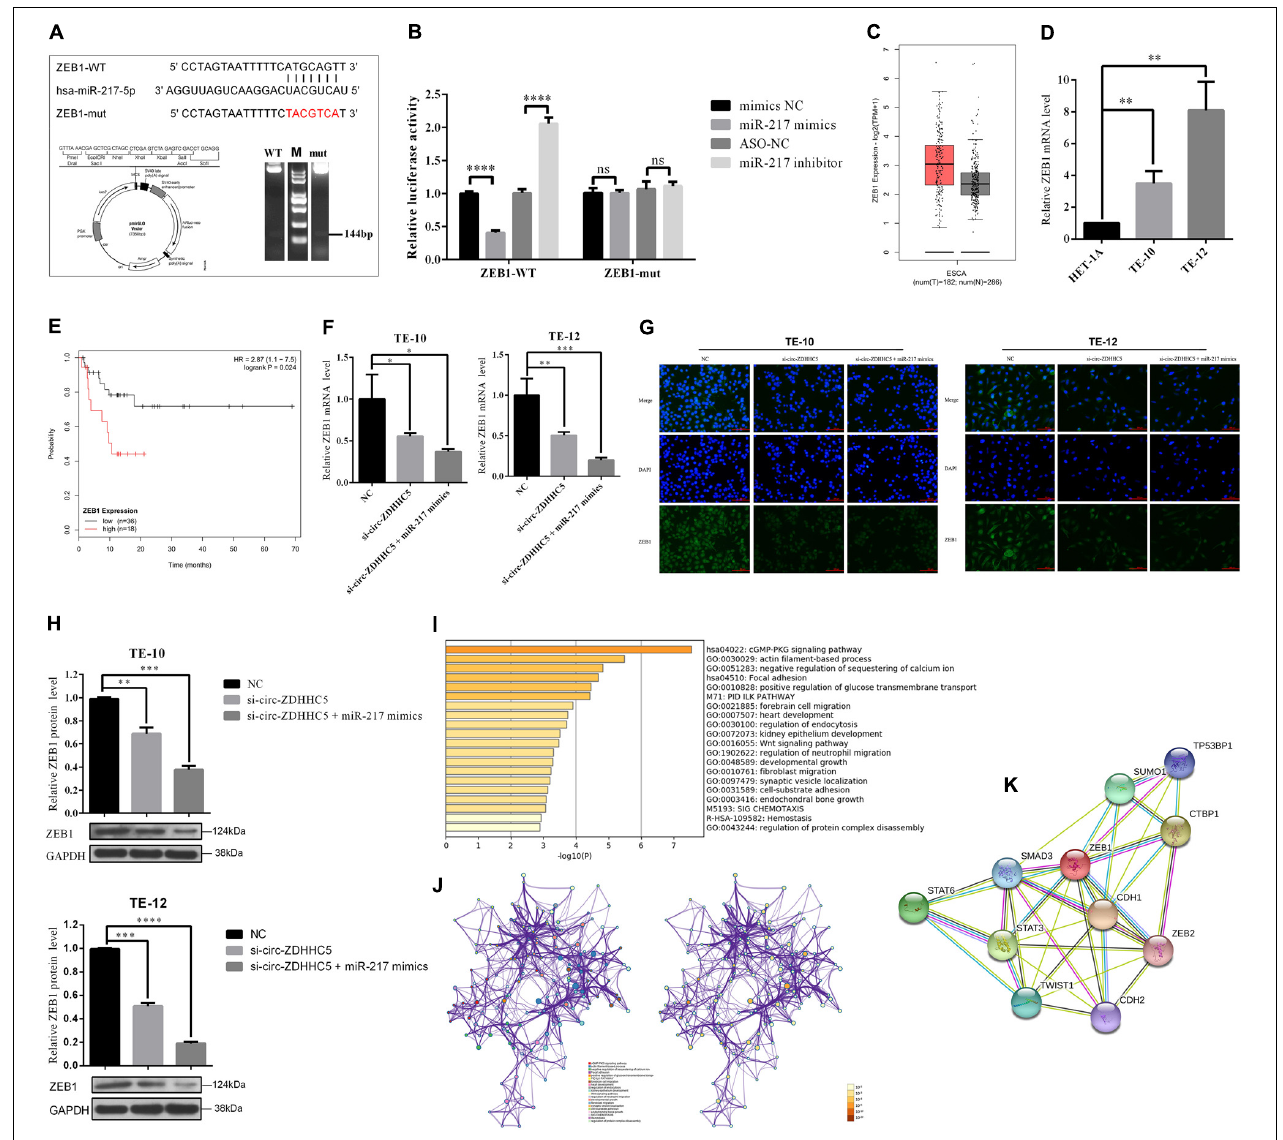
FIGURE 4 | Circ-ZDHHC5 accelerates the proliferation of ESCC by sponging miR-217 for regulating ZEB1. (A) The schematic of ZEB1 3 (cid:48) UTR wild-type (WT) and mutant (Mut) luciferase reporter vector is presented. (B) The relative luciferase activities were explored in 293T cells co-transfected with miR-217 mimics or inhibitors in-296-5p or in-NC. (C) The significant expressions of ZEB1 mRNA in ESCA tissues and normal tissue. (D) The relative expressions of ZEB1 mRNA with qRT-PCR in ESCC cells. (E) Kaplan-Meier overall survival curve of patients with more significant ZEB1 expression. (F) The expression levels of ZEB1 mRNA were explored with qRT-PCR in ESCC cells when co-transfected with si-circ-ZDHHC5 or si-circ-ZDHHC5 + miR-217 mimics. (G) The expression of ZEB1 protein noticeably decreased in ESCC cells by being co-transfected with si-circ-ZDHHC5 and miR-217 mimics. (H) The relative ZEB1 protein expressions were determined with Western Blot in cells transfected with si-circ-ZDHHC5 + miR-217 mimics. (I) Functional enrichment summary of co-expression genes with ZEB1. (J) Network of ZEB1 gene and the top 100 co-expression genes. The left is colored by cluster ID and nodes sharing the identical cluster are typically close to each other. The right is colored by p -value and terms covering more genes may achieve a more noticeable p -value. (K) The interaction network of ZEB1 and the proteins being able to bind to ZEB1 directly. (* p < 0.05, ** p < 0.01, *** p < 0.001, **** p <